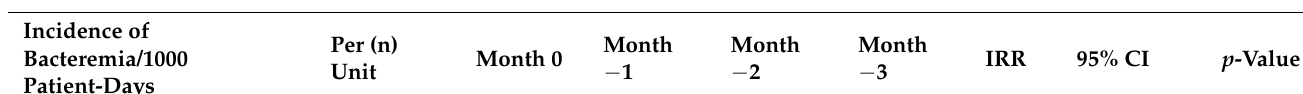
Table 5. Cont. CAUTI: Correlation with